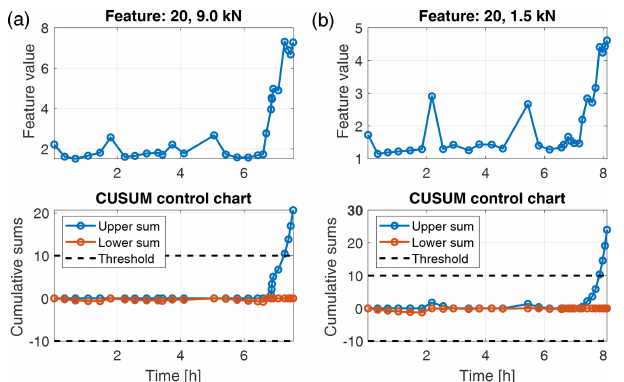
Figure 8. Feature values and CUSUM control charts for feature 20 in the ALT test for load 9.0kN (a) and 1.5kN (b) .